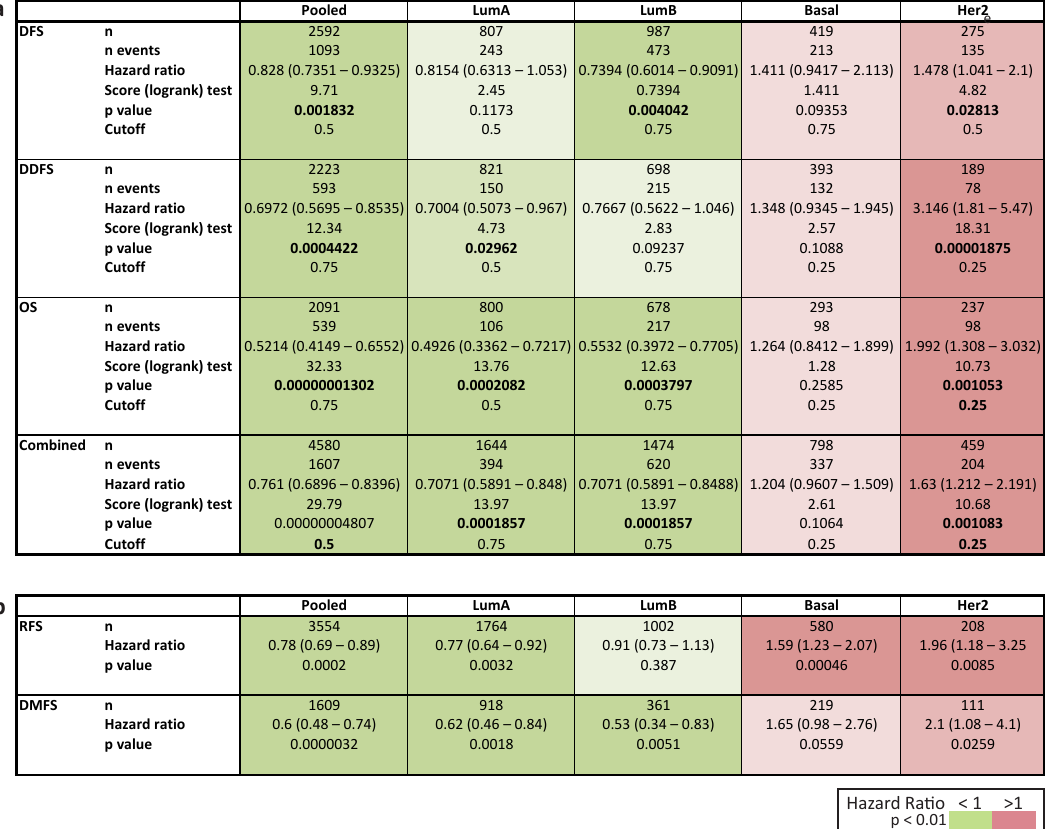
Figure A7. GJA1 is associated with different outcomes depending on the breast cancer subtype. ( a ) BreastMark’s; and ( b ) KMPlotter’s web interface were used to complete the survival analysis for GJA1 expression. Disease-Free Survival (DFS), Distant Disease-Free survival (DDFS), Overall Survival (OS) and Combined Survival (Combined) are given either for pooled tumors or for individual breast cancer subtypes in Breast Mark ( a ). Relapse-Free Survival (RFS) and Distant Metastasis-Free survival are given for GJA1 probe 201667_at in KMPlotter ( b ). The best cutoff was determined manually for BreastMark (25, 50 or 75 percentile) based on p value and logrank score and automatically for